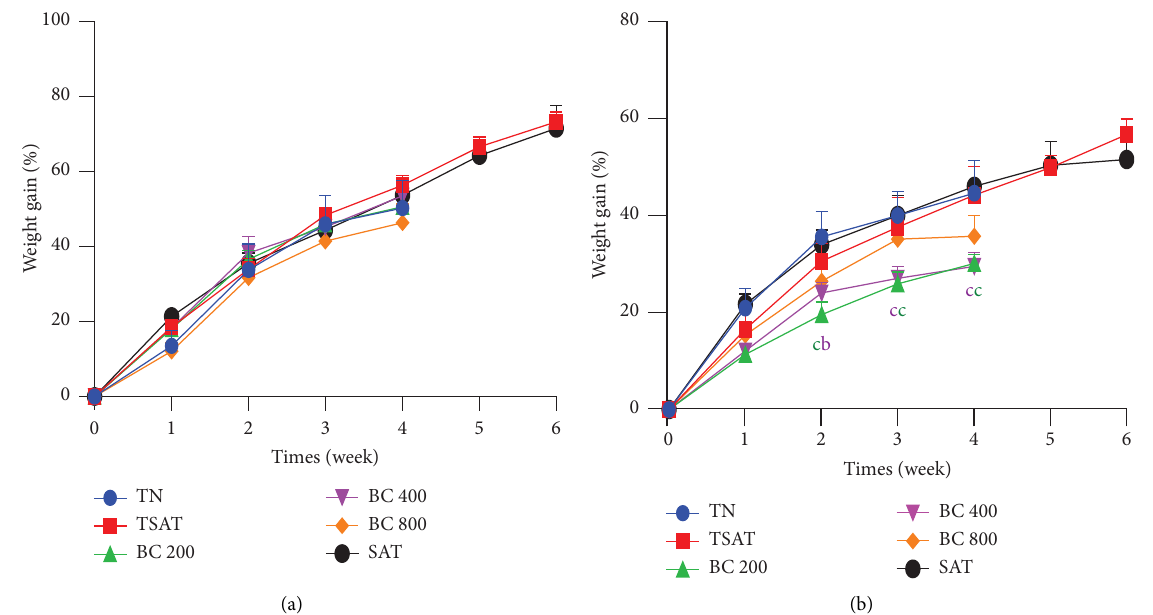
Figure 2: Efects of the plant mixture aqueous extract on the weight evolution of male (a) and female (b) rats in subchronic toxicity. Each point represents the mean ± SEM. n � 5. TN: normal rats receiving distilled water (10mL/kg); TSAT: normal satellite observed 14 more days after stopping every treatment; BC 200, BC 400, and BC 800: animals receiving the aqueous extract of the mixture of B. pilosa and C. citratus at the respective doses of 200, 400, and 800mg/kg; SAT: satellite extract at the dose of 800mg/kg observed 14 days after stopping every treatment. b p < 0 . 01; c p < 0 . 001: signifcant diference from normal controls. Table 2: Efects of the plant mixture aqueous extract on the relative weight of organs of females. Organs TN TSAT SAT